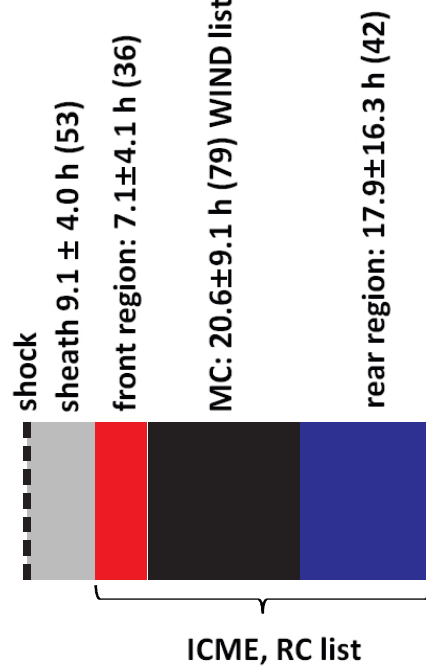
Fig. 1. This figure shows the shock, sheath and different regions within an ICME. Note that not all ICMEs are fast enough to drive shocks, and thus they do not have a well-defined sheath region ei- ther. The ICME interval is obtained from the Richardson and Cane ICME list, and the MC interval from the Wind magnetic cloud list. The widths are scaled to represent relative average durations of dif- ferent regions for our data set (given in the figure and followed by standard deviations). The numbers in parenthesis represent the num- ber of events used to calculate the average